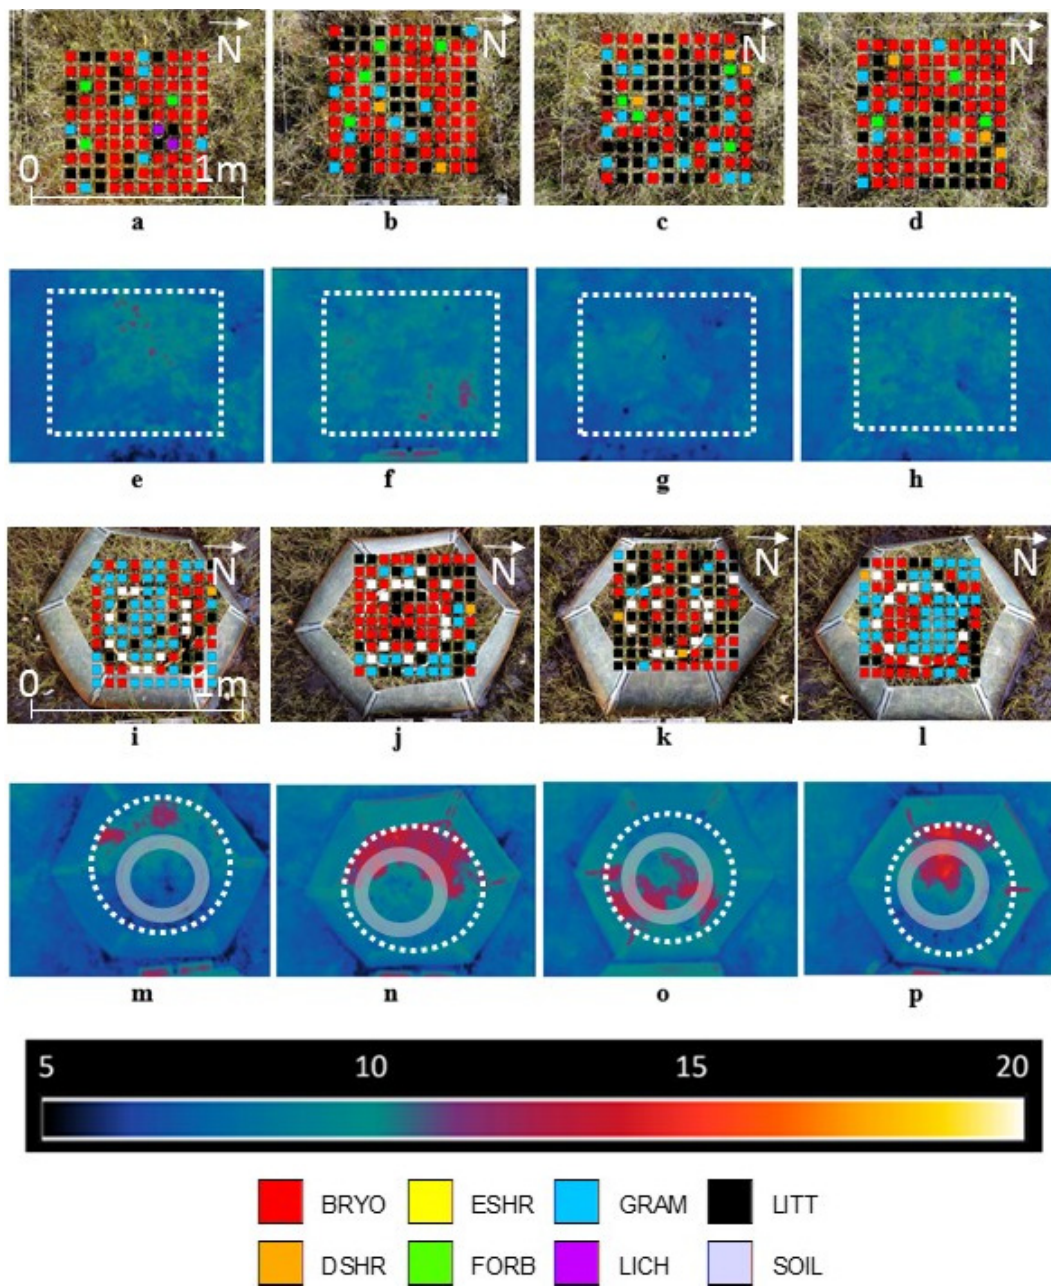
Figure 6. Images depicting four Atqasuk wet site plots ( a – d ) and the coinciding thermal images below ( e – h ); and images of four additional plots ( i – l ) with coinciding thermal images below ( m – p ). Note: the rings appearing in panels ( i – p ) are gas exchange collars not related to this study. Areas of image analysis are outlined with dotted white lines. Data in the transparent circular areas have been removed. All temperatures are in degrees Celsius. Plant growth forms and surface features are depicted with the following abbreviations—BRYO: bryophyte/moss; DSHR: deciduous shrub; ESHR: evergreen shrub; FORB: forb; GRAM: graminoid; LICH: lichen; LITT: leaf litter; SOIL: bare soil/rock. White grids symbolize chamber base points or plant identification tags.